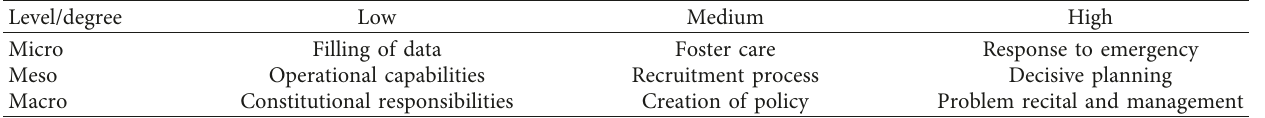
Table 3: Analysis of task by level and decision degree.